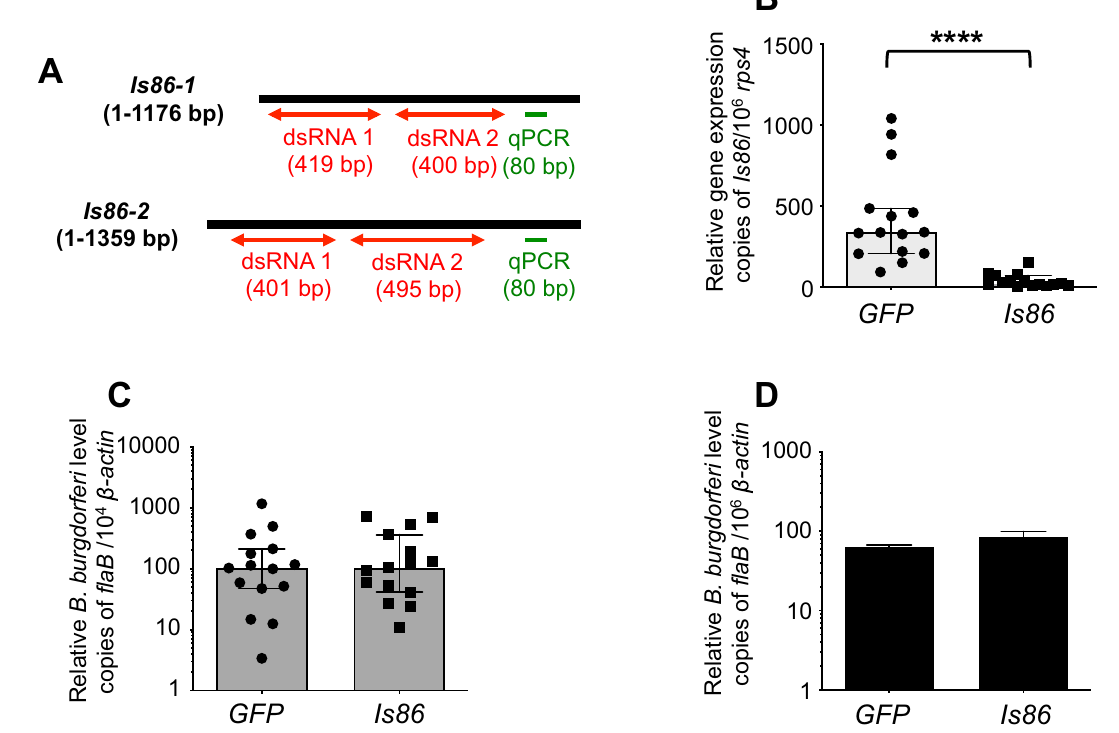
Figure 6. Silencing of Is86 fails to interfere with B. burgdorferi persistence in ticks and spirochete transmission. ( A ) Schematic representation of the full open reading frame of Is86-1 and Is86-2 , showing regions targeted for RNA interference. The regions encompassing dsRNA constructs (red arrows) and detection primers that contain common sequences in both Is86-1 and Is86-2 (green) are shown. ( B ) RNAi induced a significant knockdown of Is86 transcripts (****p < 0.0001). The levels of Is86 gene transcripts in ticks that had been microinjected with pooled dsRNAs targeting Is86-1 and Is86-2 were significantly decreased compared to the ds GFP RNA control. ( C ) Silencing of Is86 did not affect spirochete persistence in ticks. Spirochete burdens in fully replete ticks were assessed using qPCR and normalizing against tick β-actin . ( D ) Silencing of Is86 did not block B. burgdorferi transmission from ticks. Spirochete burdens in murine skin were assessed using qPCR. The bars represent the mean ± SEM of four qPCR analyses of B. burgdorferi levels, derived from two independent animal